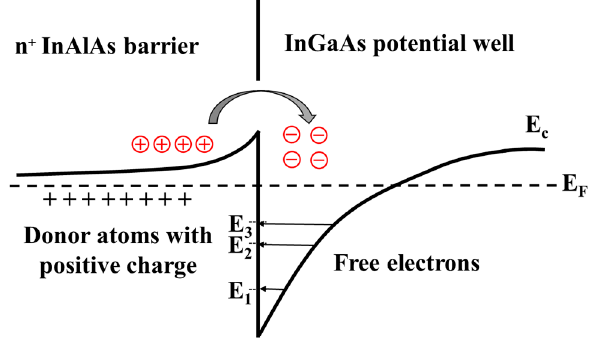
Figure 54. Band structure of n + InAlAs/InGaAs heterojunction.